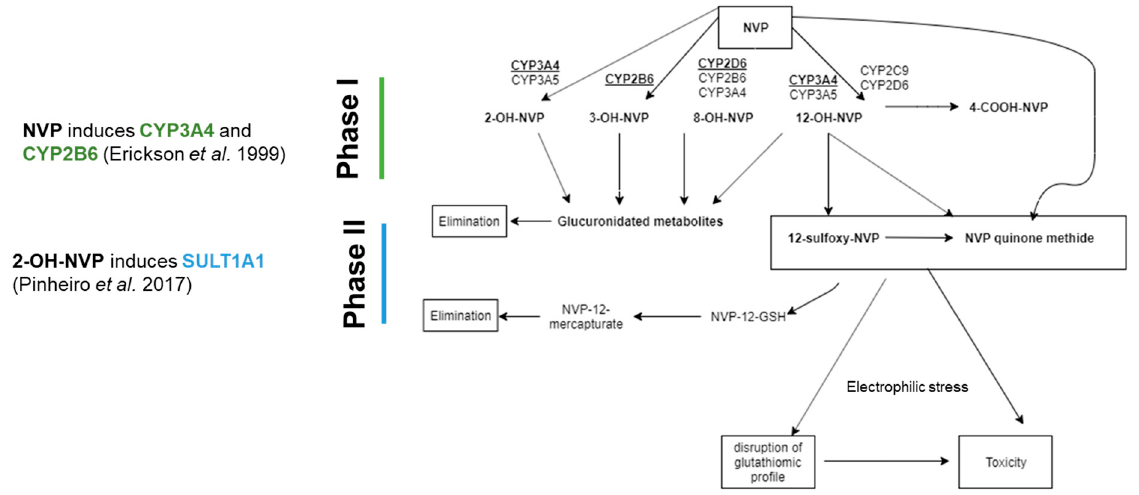
Figure 1. Schematic representation of Nevirapine (NVP) biotransformation and toxic metabolites formation.